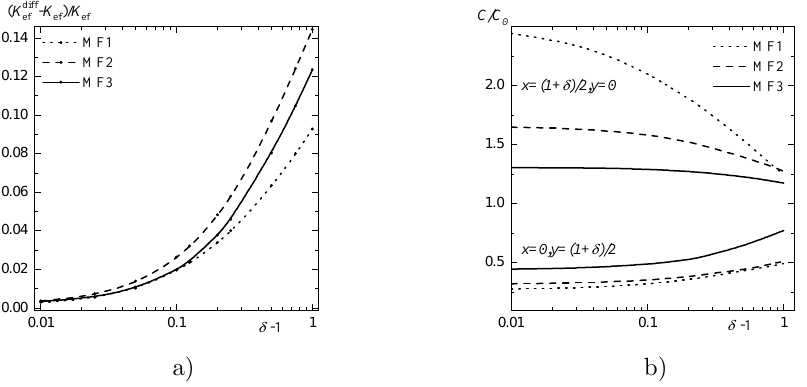
Figure 5. a) Dependence of the relative error (cid:0) K diff − K ef (cid:1) /K ef for the shielding ef effectiveness factor, computed as K diff for a non-uniform particle distribution and as K ef ef for a uniform one, versus the dimensionless layer thickness δ − 1. b) Dependence of the dimensionless concentration C/C 0 versus the dimensionless layer thickness δ − 1 at the two control points x = (1 + δ ) / 2 ,y = 0 and x = 0 ,y = (1 + δ ) / 2 on the center line of the ferrofluid domain at r = (1 + δ ) / 2. Computations are made for model 3 at the dimensionless applied magnetic-field intensity h 0 =